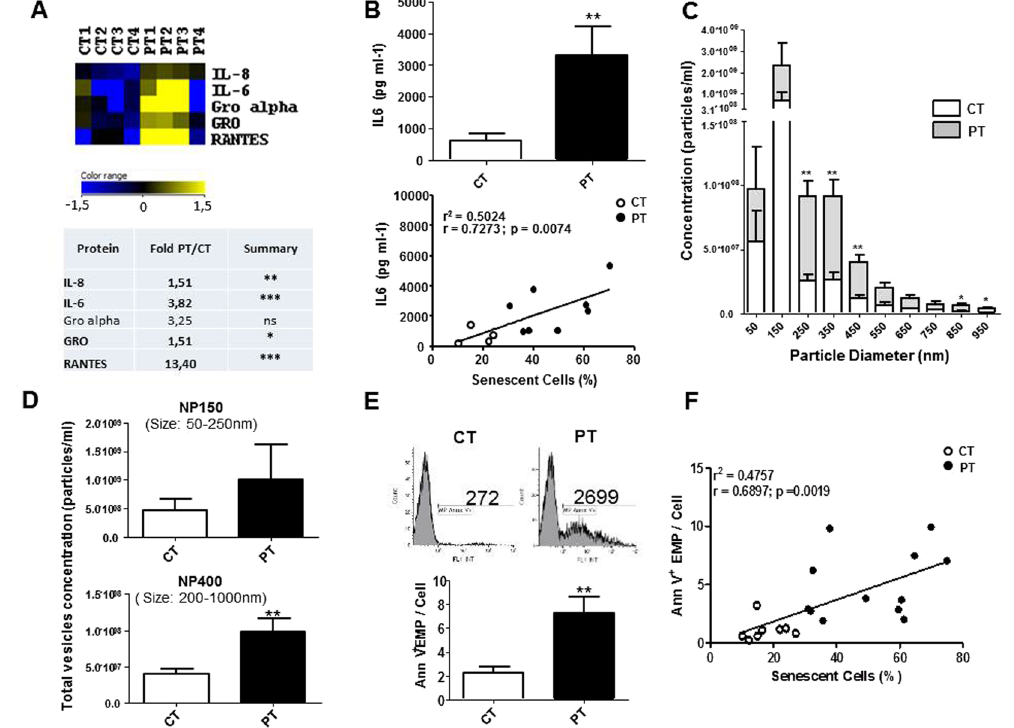
Figure 1. Prematurity modulates a subset of SASP. ( A ) Analysis of factors secreted by CT- and PT-ECFC using antibody arrays. CT-conditioned media signals were used as the baseline. The heat maps key represents log2-fold changes of PT-media from the baseline. Signals higher and lower than the baseline are highlighted in yellows and blue respectively. Factors that differed significantly between the CT- and PT-media are represented by an asterisk ( * ). ( B ) An ELISA assay confirmed that IL6 levels were significantly increased in conditioned media from PT vs. CT cells (upper panel, N = 9 vs. 5). Correlation between the secreted IL6 levels and the senescence percentage of ECFC (lower panel). ( C ) The qNano profiles of the concentrations of unfractionated raw vesicles for CT and PT-media using NP150 and NP400 nanopores (N = 5 vs. 6). ( D ) Size distribution of endothelial vesicles from CT- and PT-media, as estimated by qNano. The figure depicts the diameter of the vesicles (in nm) versus the normalized concentration of vesicles (in particles/ml). 60-nm bin size. ( E ) Comparison of levels of Annexin-V + EMP of CT- and PT-media (N = 11 vs. 16). Representative plots and quantification of EMP measurements by flow cytometry (size of 0.1–1 µ m that stained positively for Annexin-V). ( F ) Correlation between Annexin-V + EMP levels and the senescence percentage of ECFC (N = 20). The data for all the bar graphs are presented as the means ± SEM. (Statistical analyses: Mann Whitney, Unpaired t-test; * p < 0.05, ** p < 0.01, *** p <